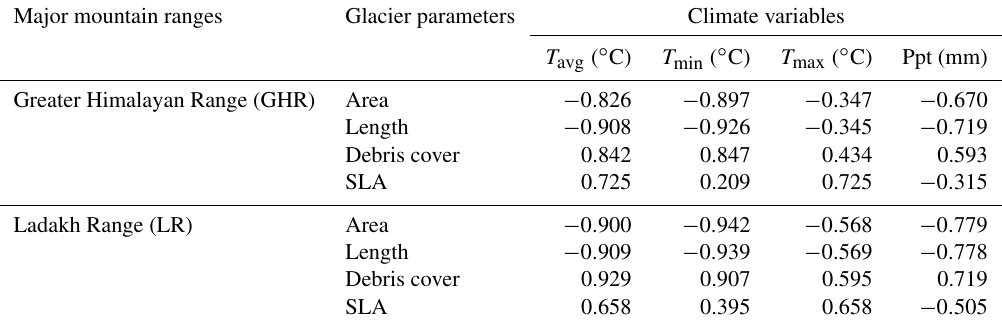
Table 3. Coefficients of determination ( r ) between respective meteorological (temperature and precipitation) data and observed glacier parameters in the Greater Himalayan Range (GHR) and Ladakh Range (LR) at 90% confidence. T avg , T min and T max are monthly mean, monthly mean minimum and monthly mean maximum temperatures, and Ppt is monthly mean precipitation at a different point in time (1971, 1994, 2000 and 2017). Major mountain ranges Glacier parameters Climate variables T avg ( ◦ C) Greater Himalayan Range (GHR) Area − 0 . 826